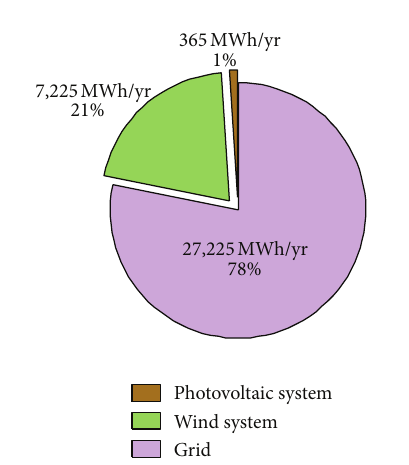
Figure 10: Power injected into the grid.